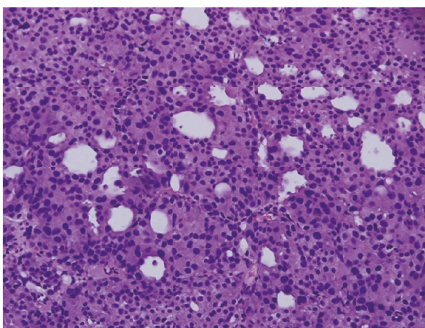
Figure 3: Hematoxylin and eosin (H&E) examination of the core needle biopsy of the mediastinal mass ( × 20).